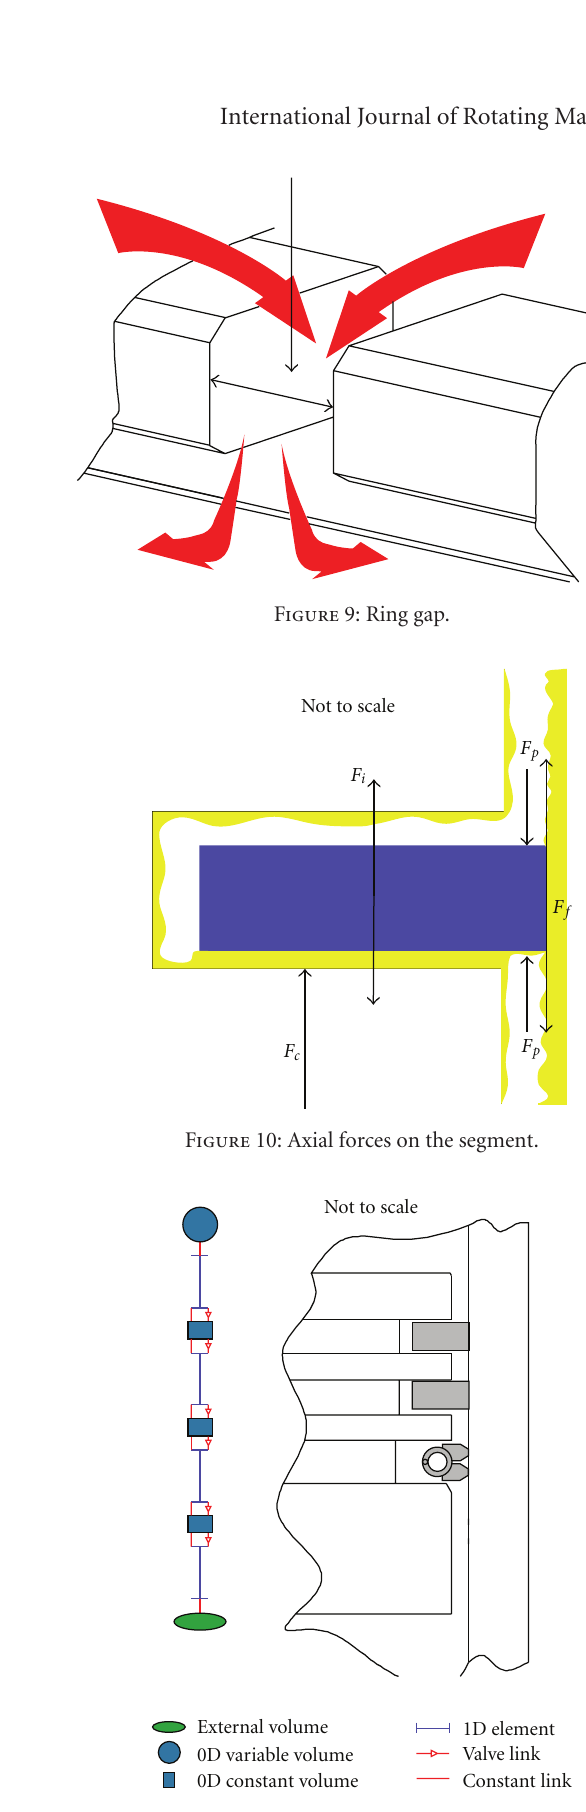
Figure 11: 0D-1D PRL